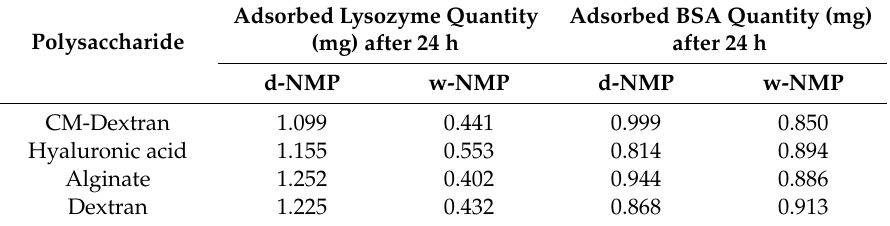
Table 3. Adsorption of Lysozyme and BSA in NMPs ( d: Dimethyl Sulphoxide; w: Water